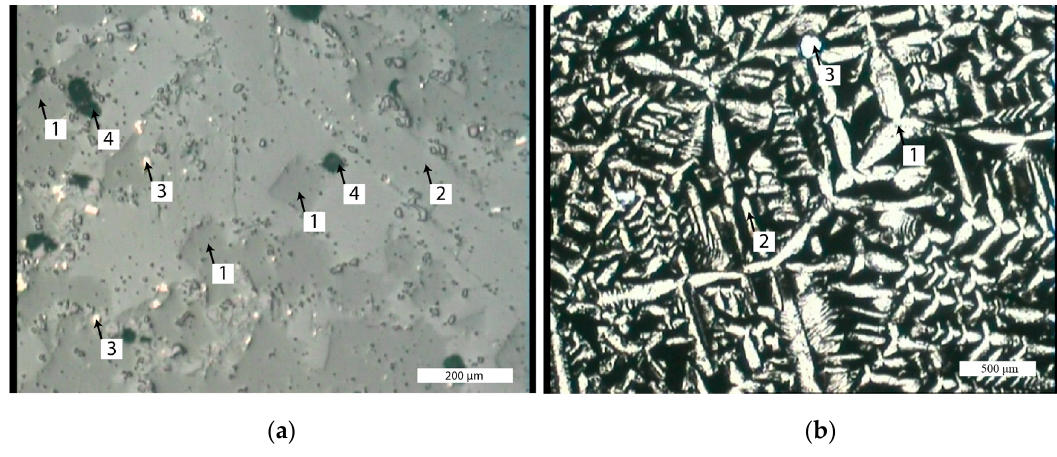
Figure 10. Microstructure of slag. ( a ) Reflected light; ( b ) transmitted light.